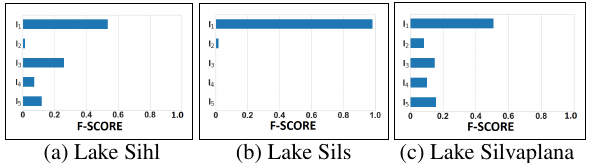
Figure 6: Relative F-scores for the VIIRS channels, as computed with xgboost. Best viewed on